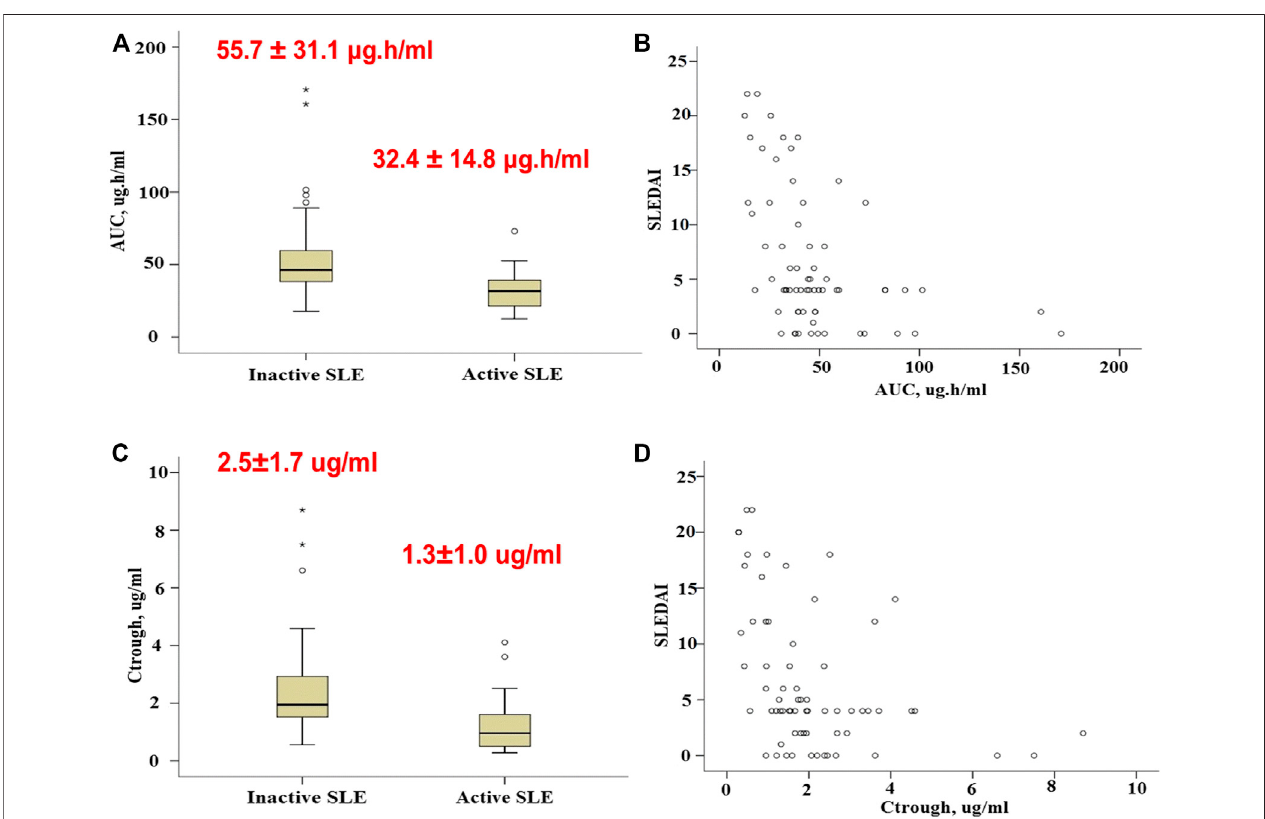
FIGURE 4 | Association of MPA exposure measures with SLE activity. (A) , Boxplots of MPA AUC 0 – 12 in patients with active and inactive SLE. (B) , Association of MPA AUC 0 – 12 with the SLEDAI score. (C) , Boxplots of C trough in patients with active and inactive SLE. (D) , Association of C trough with the SLEDAI score. Each box represents the 25th to 75th percentiles. Lines outside the boxes represent the 10th and the 90th percentiles. Lines inside the boxes represent the median.